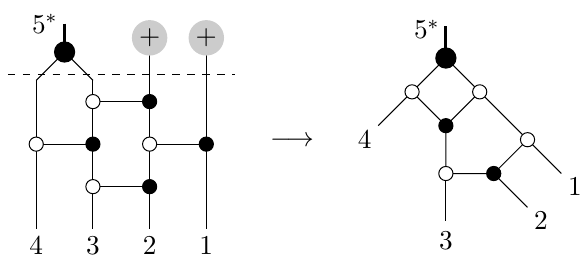
Figure 5 . On-shell diagram construction via BCFW bridges for A (cid:3)